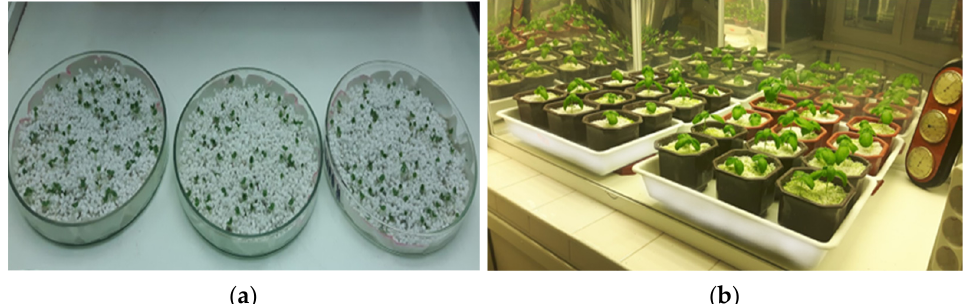
Figure 1. Setting up the experiment. ( a ) Eight days seedlings filled with substrate perlite; ( b ) Seedlings transplanted into the pots filled with substrate perlite.